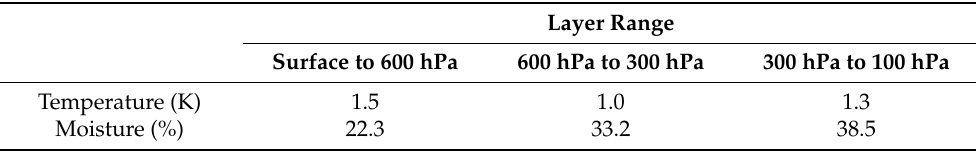
Figure 9. ( a ) The spatial distribution of the density of the retrieval samples (/100 km 2 ) between the HIRAS and ERA5 data. ( b ) The count of retrieval samples in the 1 ◦ latitudinal bands. ( c ) The count of retrieval samples in the 10 ◦ latitudinal bands. Table 2. The RMSE and bias of temperature and relative humidity between the retrieval results and ERA5 data in three broad